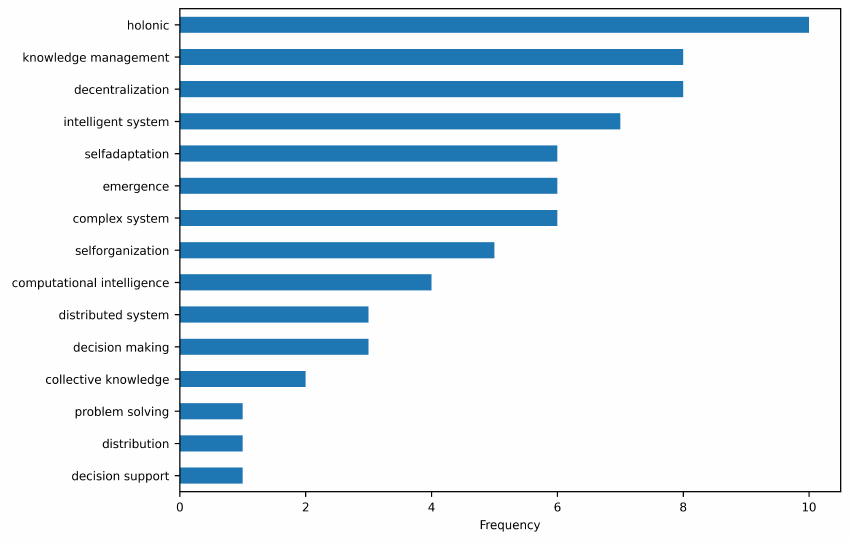
Figure 5. Supporting concepts for collective intelligence.